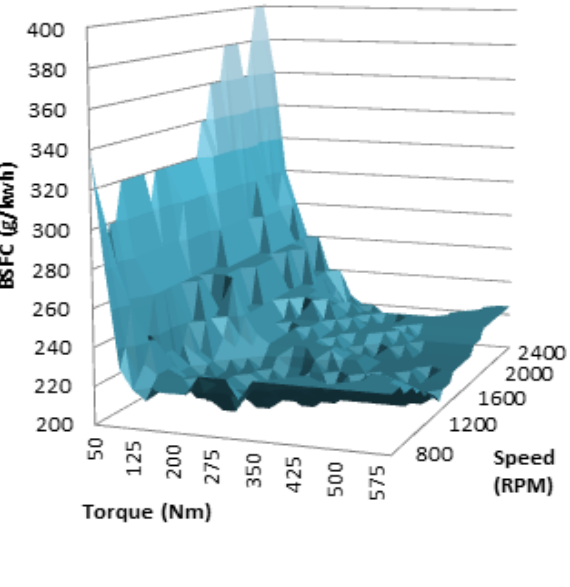
Figure 6. Internal combustion engine fuel